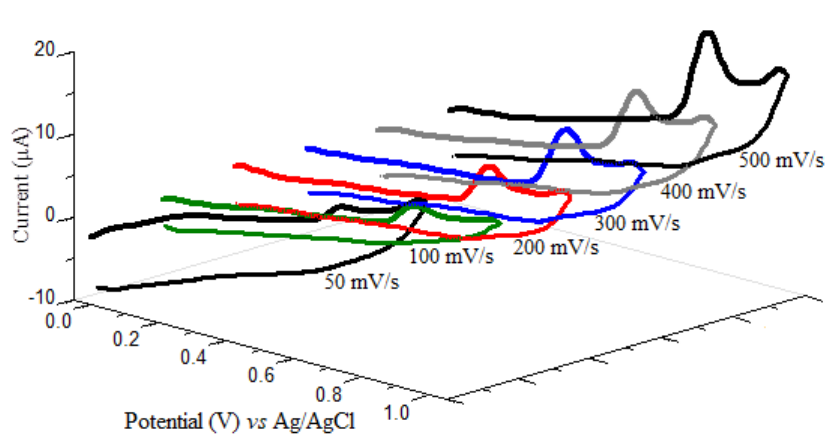
Figure 2. Cyclic voltammograms of 10 mg/L oxyclozanide in pH 2.0 Britton–Robinson (BR) buffer at carbon paste electrode (CPE) at different scan rates.